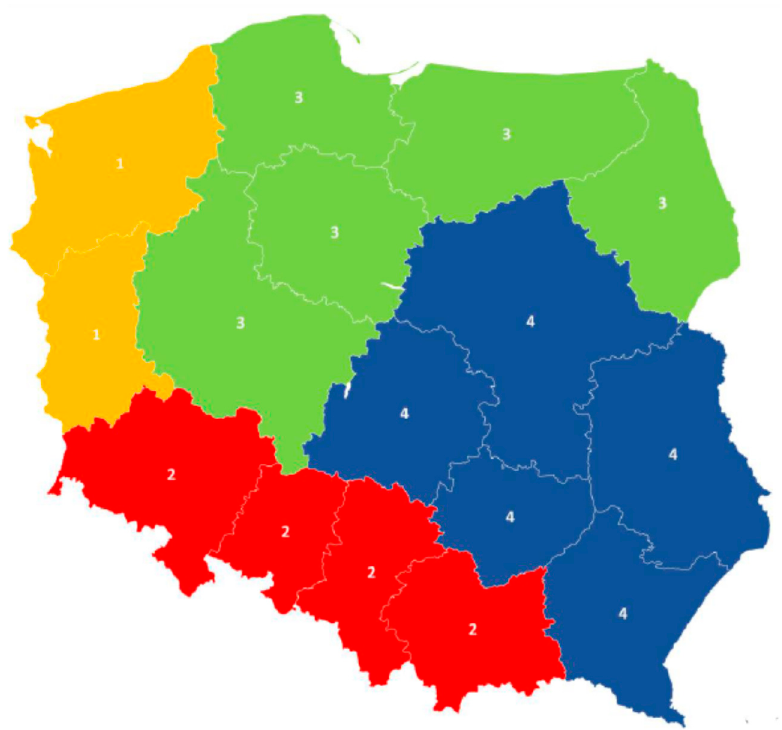
Figure 8. The division of Poland into homogeneous regions with regard to the NPV value on a macroeconomic level.